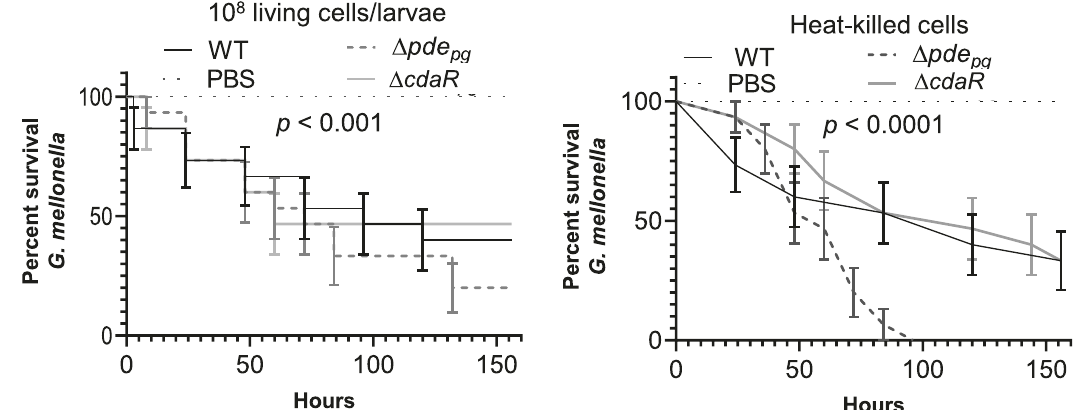
Fig. 6 Survival of G. mellonella larvae injected with ∼ 10 8 CFU/ml of P. gingivalis WT, Δ pde pg , and Δ cdaR mutants. The control group was injected with sterile PBS. Survival data were plotted using the Log-rank (Mantel – Cox) test. Graph shows the average of two biological replicates and the standard error ( n = 15 larvae per